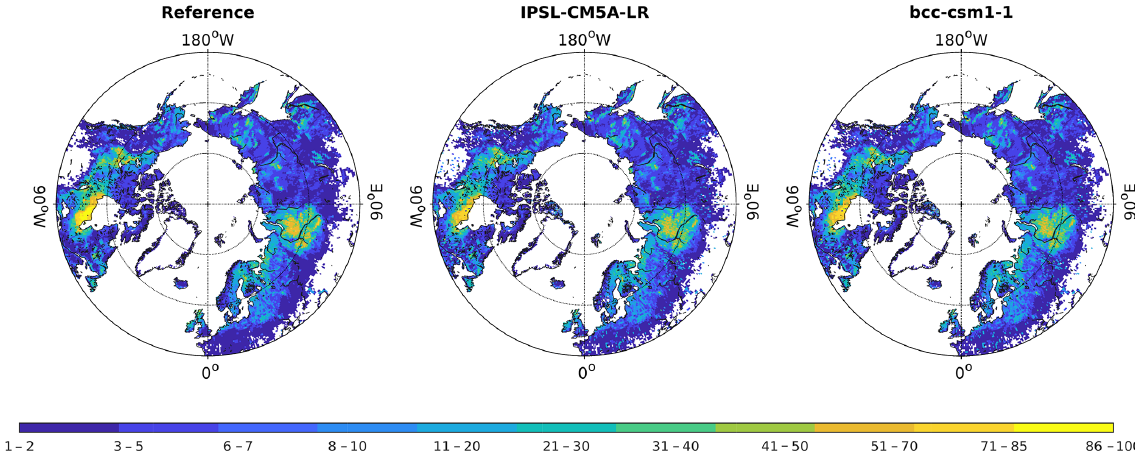
Figure 2. Comparison between the reference and calibrated wetland abundance (%) during 1940–1990 interpolated with the TOPMODEL approach. The reference dataset is the average peatland abundance of three peatland maps (Xu et al., 2018; Hugelius et al., 2020; Melton et al., 2022), and calibration is conducted for IPSL-CM5A-LR and bcc-csm1-1 climate inputs. The grid cells with less than 1% wetlands are left blank. This is the initial wetland extent for future peatland